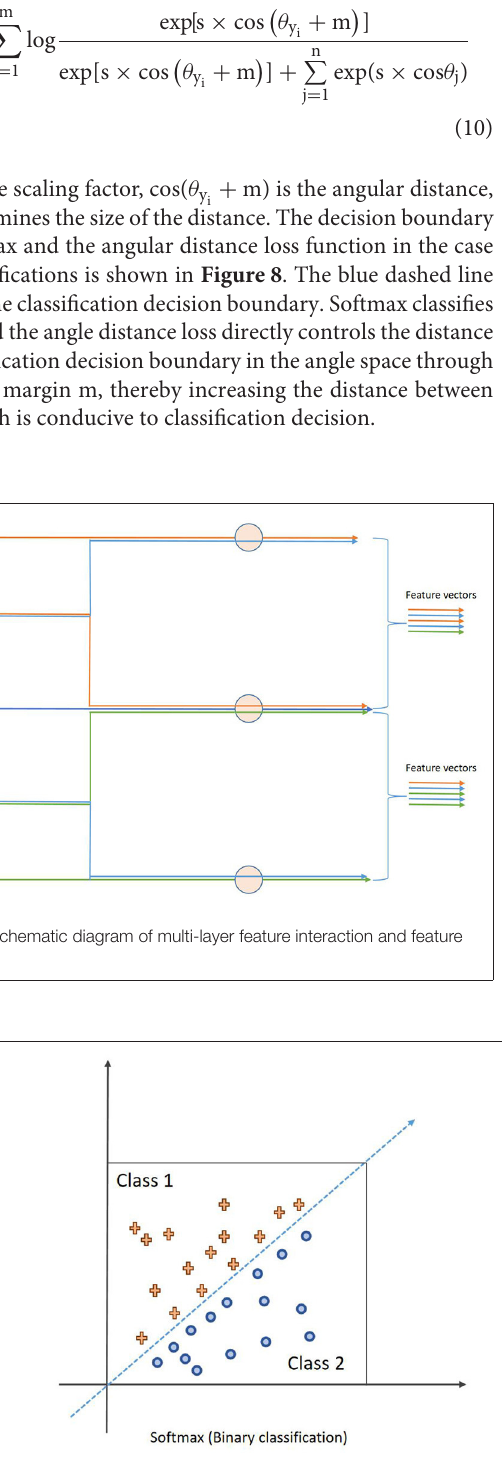
FIGURE 8 | Schematic diagram of angular distance